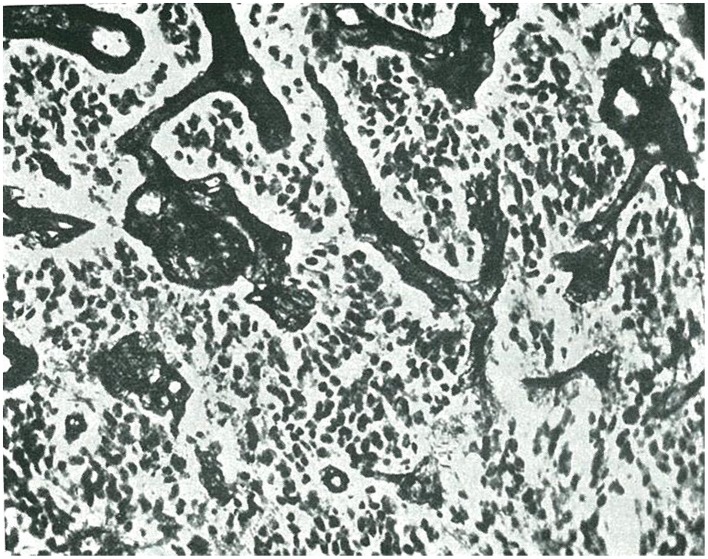
Isomorphic glioblastoma, as termed by Rio-Hortega (taken from Río-Hortega, 1933a).